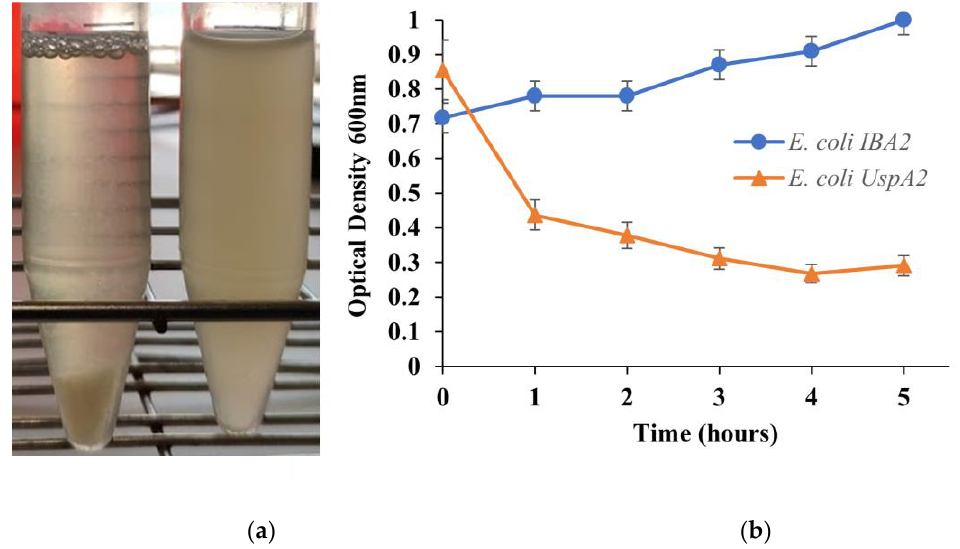
Figure 1. Illustration of a sedimentation assay. ( a ) Macroscopic analysis of auto-aggregation. Within a few minutes, Escherichia coli UspA2 (left tube) aggregates and settles at the bottom of the tube under static incubation, whereas the control culture of E. coli carrying the empty vector pASK IBA2 ( E. coli IBA) (right tube) remains turbid. ( b ) Measurement of auto-aggregation. Culture samples were incubated statically and the OD 600nm value at the top of the culture tube was measured after 5 min of incubation. The reduction in turbidity at the top of the culture is a function of the OD 600nm value. Auto-aggregating bacteria settle at the bottom of the tube, resulting in a loss of turbidity (orange curve), whereas in negative control culture samples the reduction in turbidity is negligible (blue curve).